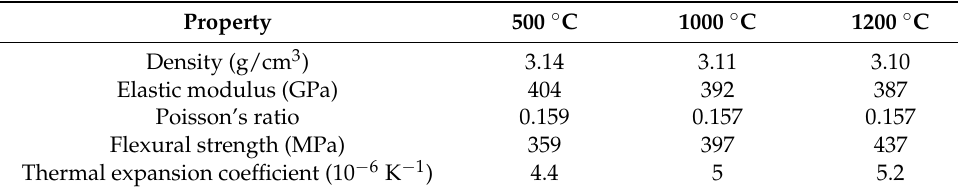
Table 3. Characteristic parameters of silicon carbide at different temperatures.